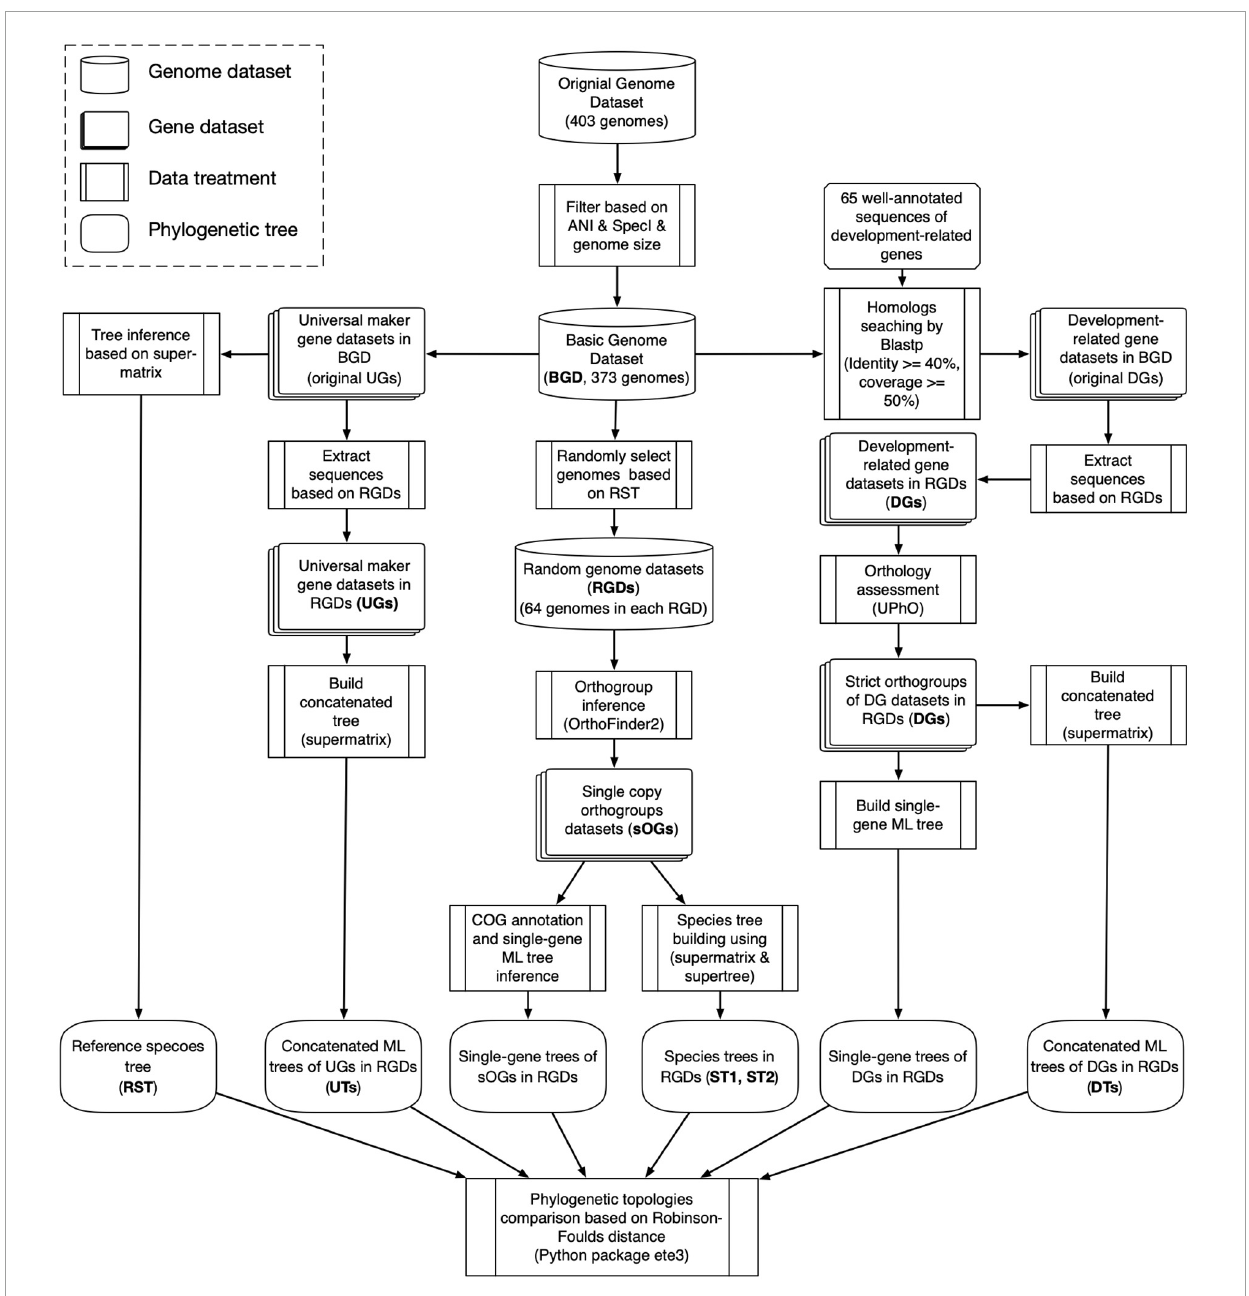
FIGURE1 Flowchart of data analysis in this study.